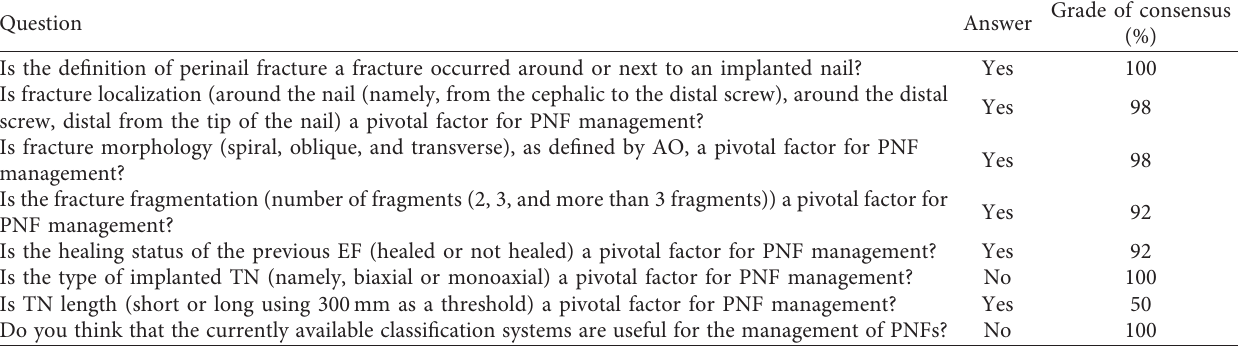
Table 1: Open question answers and grade of consensus.